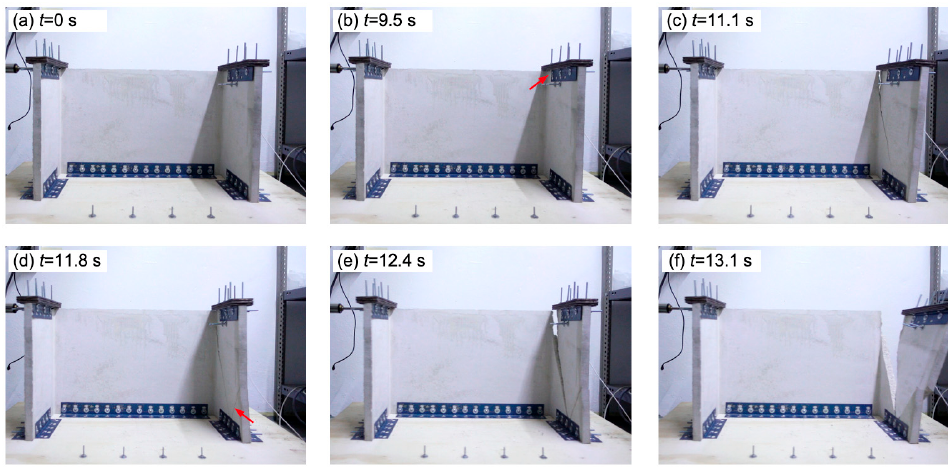
Figure 10. Collapse sequence of FRFC specimen #1: ( a ) start of the test; ( b ) formation of the first visible crack on the right flange (indicated by a red arrow); ( c ) development of the first crack; ( d ) formation of a secondary crack on the right flange (indicated by a red arrow); ( e ) development of the secondary crack; and ( f ) collapse of the right flange.